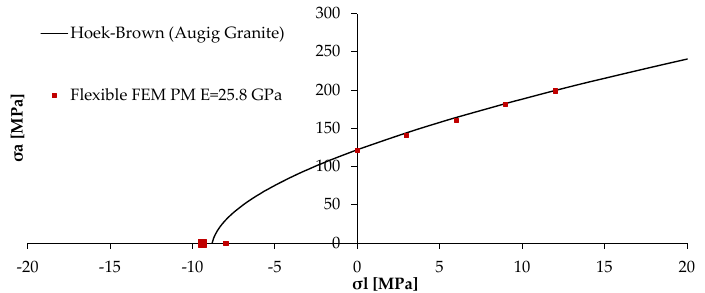
Figure 14. Strength envelope: Hoek–Brown failure criterion adopted from [11,15] and calibrated flexible FEM based particle model (bilinear constitutive model). Table 7. Contact strength properties for the proposed particle models.